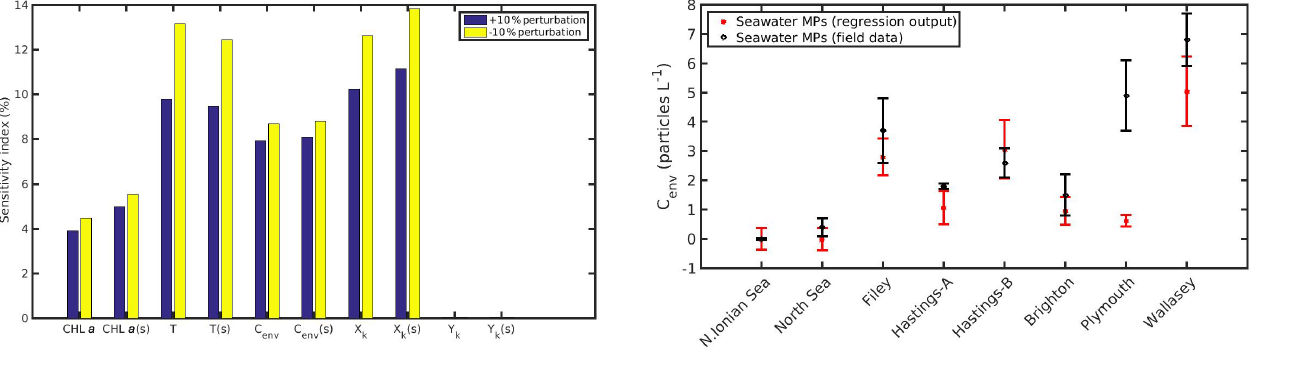
present in the North Sea compared to the N Ionian Sea. Fi-